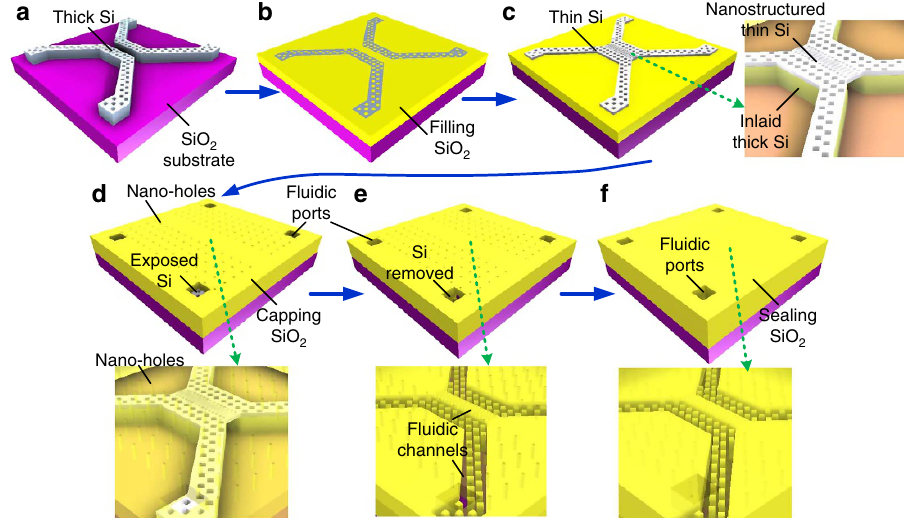
Figure 1 | Fabrication scheme of Si sacrificial nanofluidic devices. ( a ) Micrometre-thick Si microstructures fabricated on SiO 2 /Si substrates. ( b ) Planarized Si microstructures inlaid in a SiO 2 film (planarization SiO 2 ) after SiO 2 deposition and wafer polishing. ( c ) Thin Si nanostructures fabricated on top of inlaid Si microstructures. ( d ) Capping of Si fluidic structures by SiO 2 . ( e ) Fluidic ports and venting nanoholes fabricated in capping SiO 2 . ( f ) Sealing venting nanoholes by depositing SiO 2 while keeping fluidic ports open. Critical three-dimensional structures (embedded a -Si features, venting holes and vacant channels) in figures ( c – f ) are better illustrated with the top films layers intentionally set as semi-transparent (as indicated by